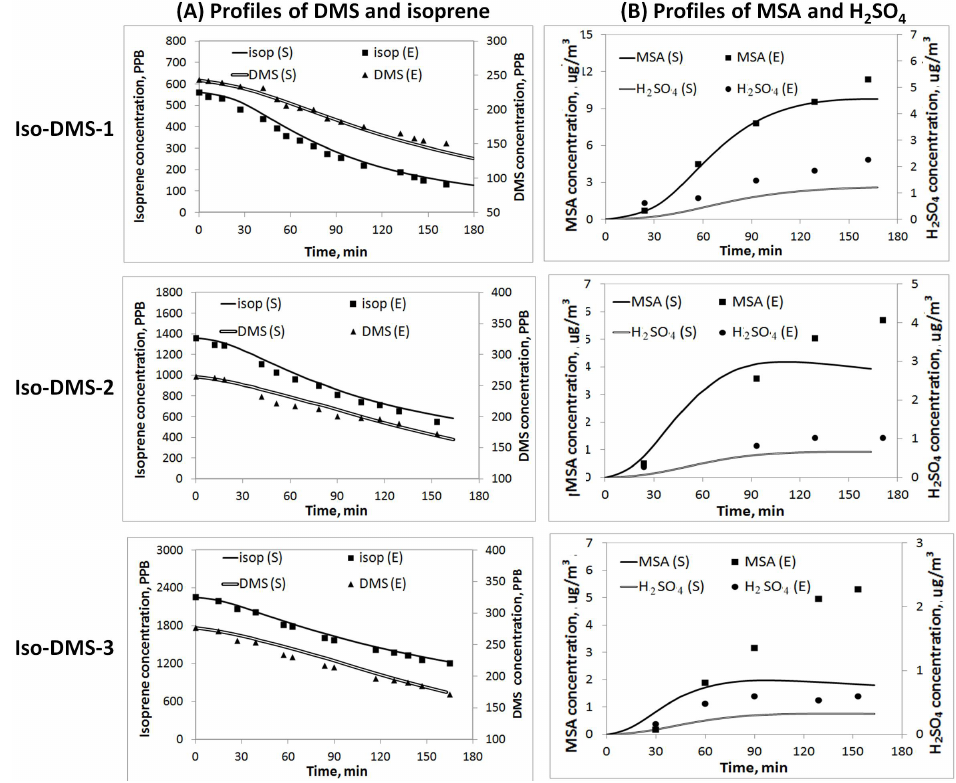
Fig. 4. Time profiles of isoprene, DMS, MSA and H 2 SO 4 for the photooxidation of DMS and NO x in the presence of 560ppb (Exp iso- DMS-1), 1360ppb (Exp iso-DMS-2), and 2248ppb (Exp iso-DMS-3) of isoprene. “E” denotes the experimentally observed concentrations of chemical species and “S” for those simulated using the kinetic model. The decay of DMS and isoprene was not corrected for the wall loss and chamber dilution while the production of MSA and H 2 SO 4 was corrected for wall loss.